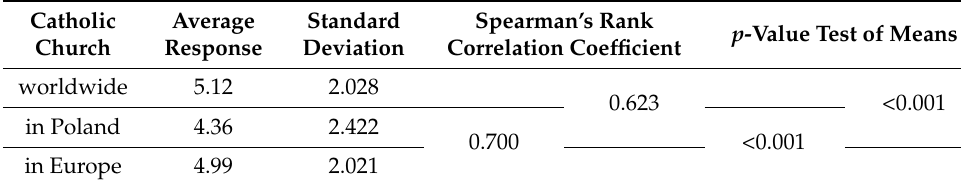
Table 5. Comparison of ratings of the image of the Catholic Church in Poland, Europe and worldwide.